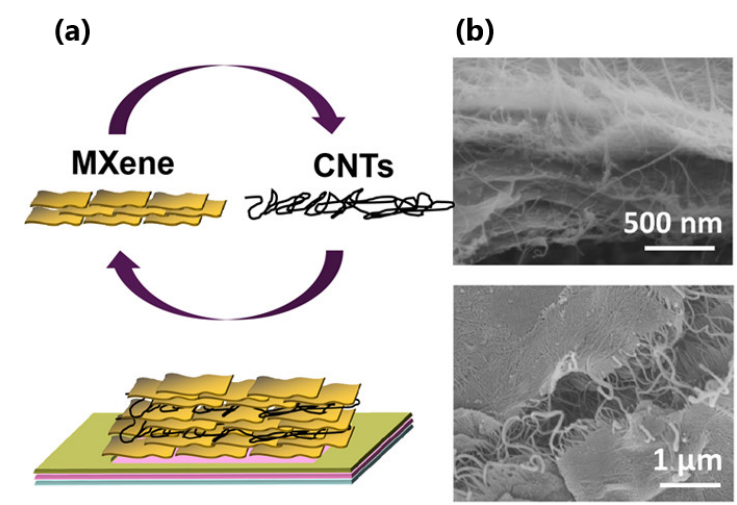
Figure 18. ( a ) Fabrication process of the Ti 3 C 2 T x MXene/CNT layer. ( b ) SEM images of the Ti 3 C 2 T x